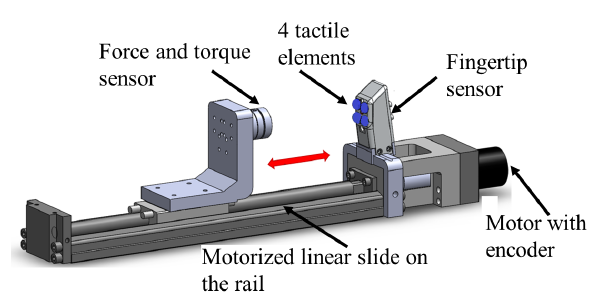
Figure 8. Calibration setup comprised from the linear motorized slide to implement repetitive movement, and a force and torque sensor to measure control forces.